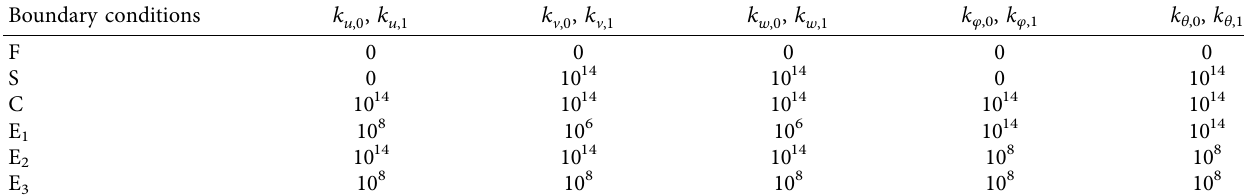
Table 2: The spring stiffness values of the elastic boundary conditions.